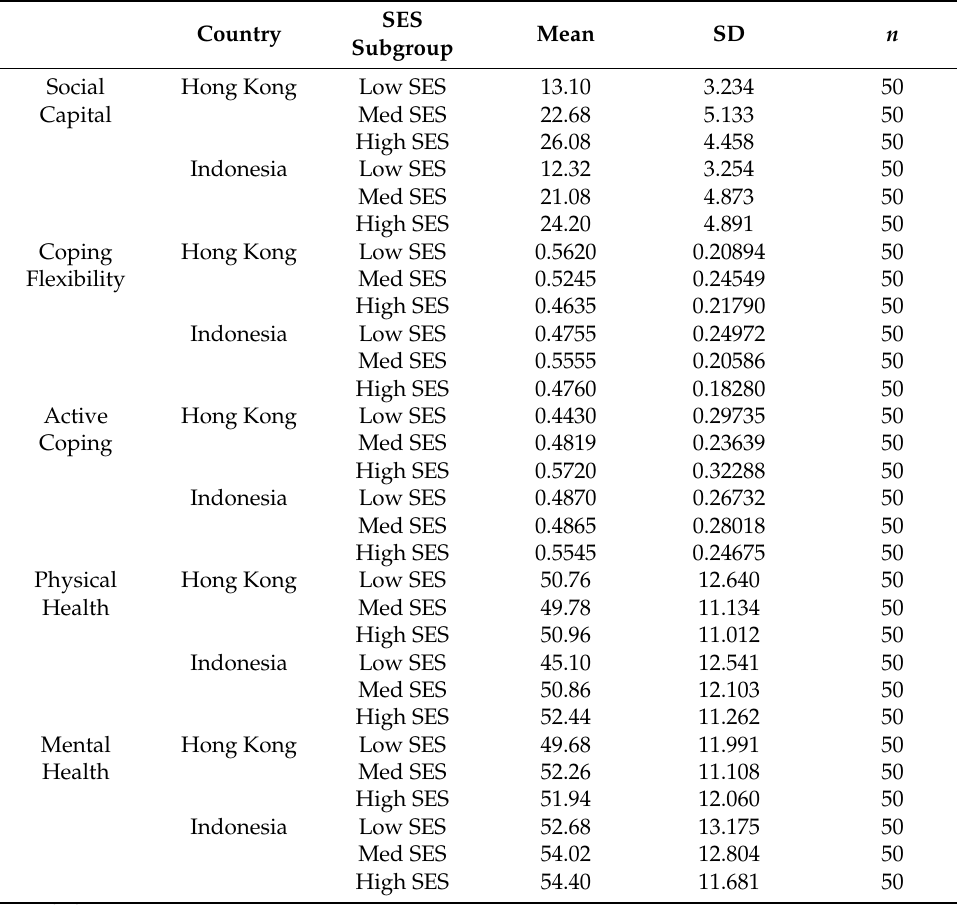
Table 1. Descriptive statistics by country and SES subgroup.